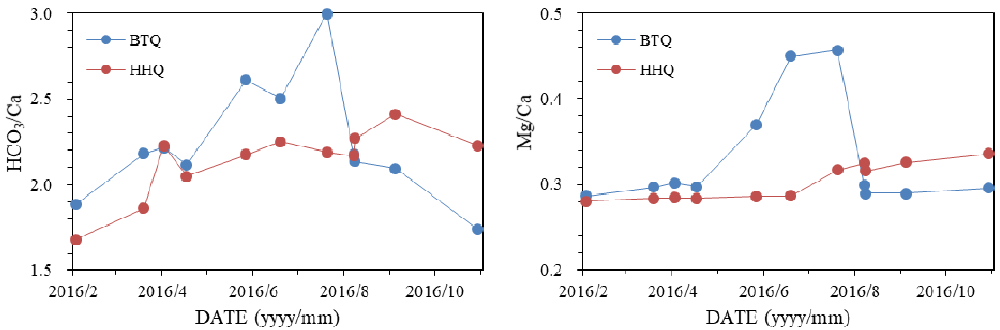
Figure 9. The temporal variation of HCO 3 /Ca and Mg/Ca in BTQ and HHQ. Except mineral dissolution, the two springs also show di ff erent responses to human